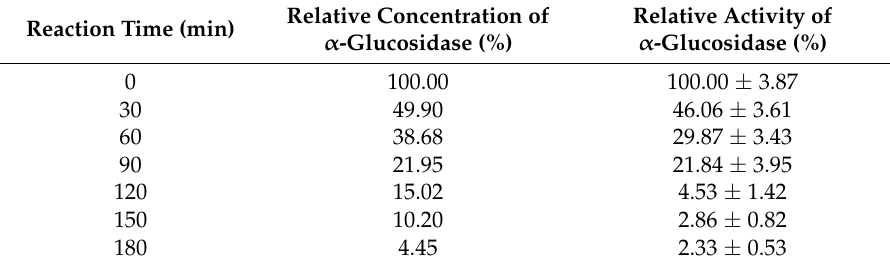
Figure 4. Lineweaver–Burk plot analysis of AAG by TKU004P. p -nitrophenyl glucopyranoside ( p NPG) was used as substrate. The concentration of TKU004P was 0 mg/mL ( ♦ ); 0.2 mg/mL (×); 0.4 mg/mL ( ▲ ); 0.8 mg/mL ( ■ ). Table 1. Result of time-course reaction of TKU004P and yeast α